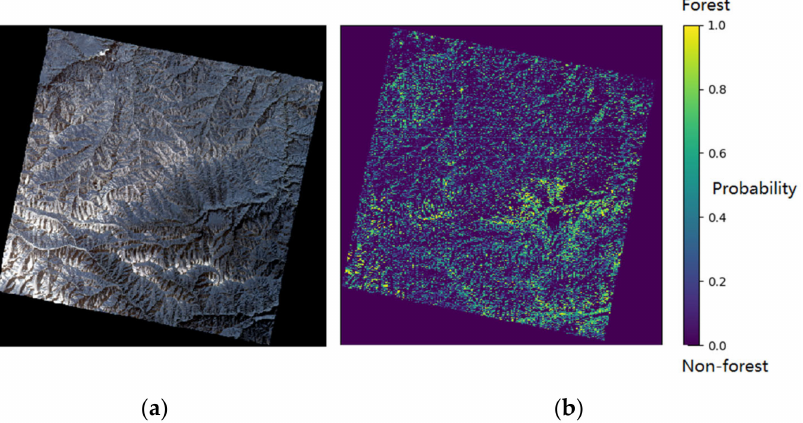
Figure 18. Visualization of a ZY-3 satellite imagery of eastern part of Sanjiangyuan National Nature Reserve on 30 June 2017: ( a ) false color composite images; ( b ) the plateau forest segmentation based on the proposed method.